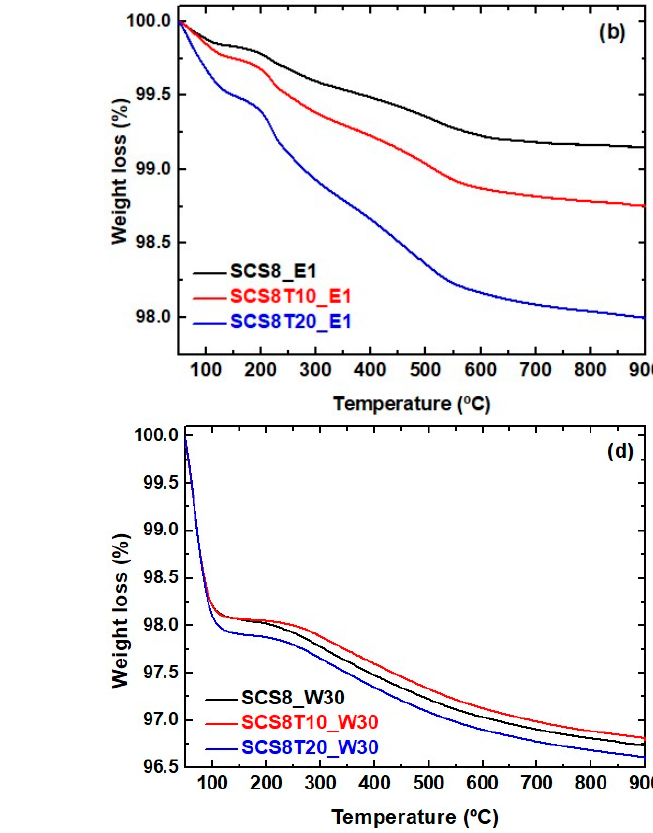
Figure 4. Thermograms of SCS8, SCS8T10, and SCS8T20 xerogels dried after four different washing procedures ( a ) U; ( b ) E1; ( c ) E7; ( d ) W30.